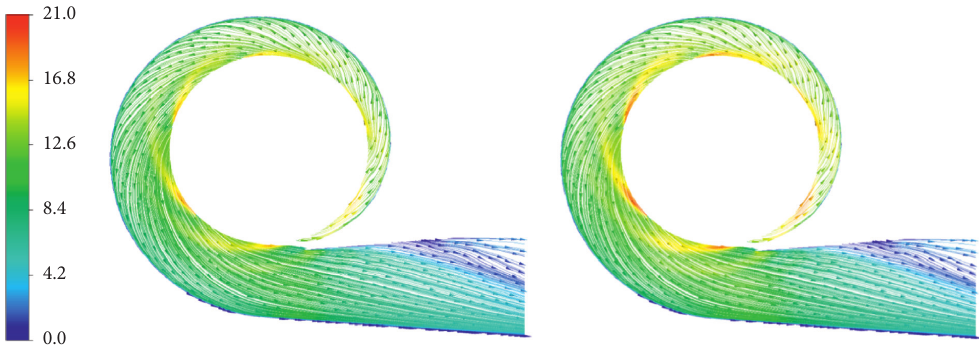
Figure 19: Velocity and streamline distribution at 0.8 Q